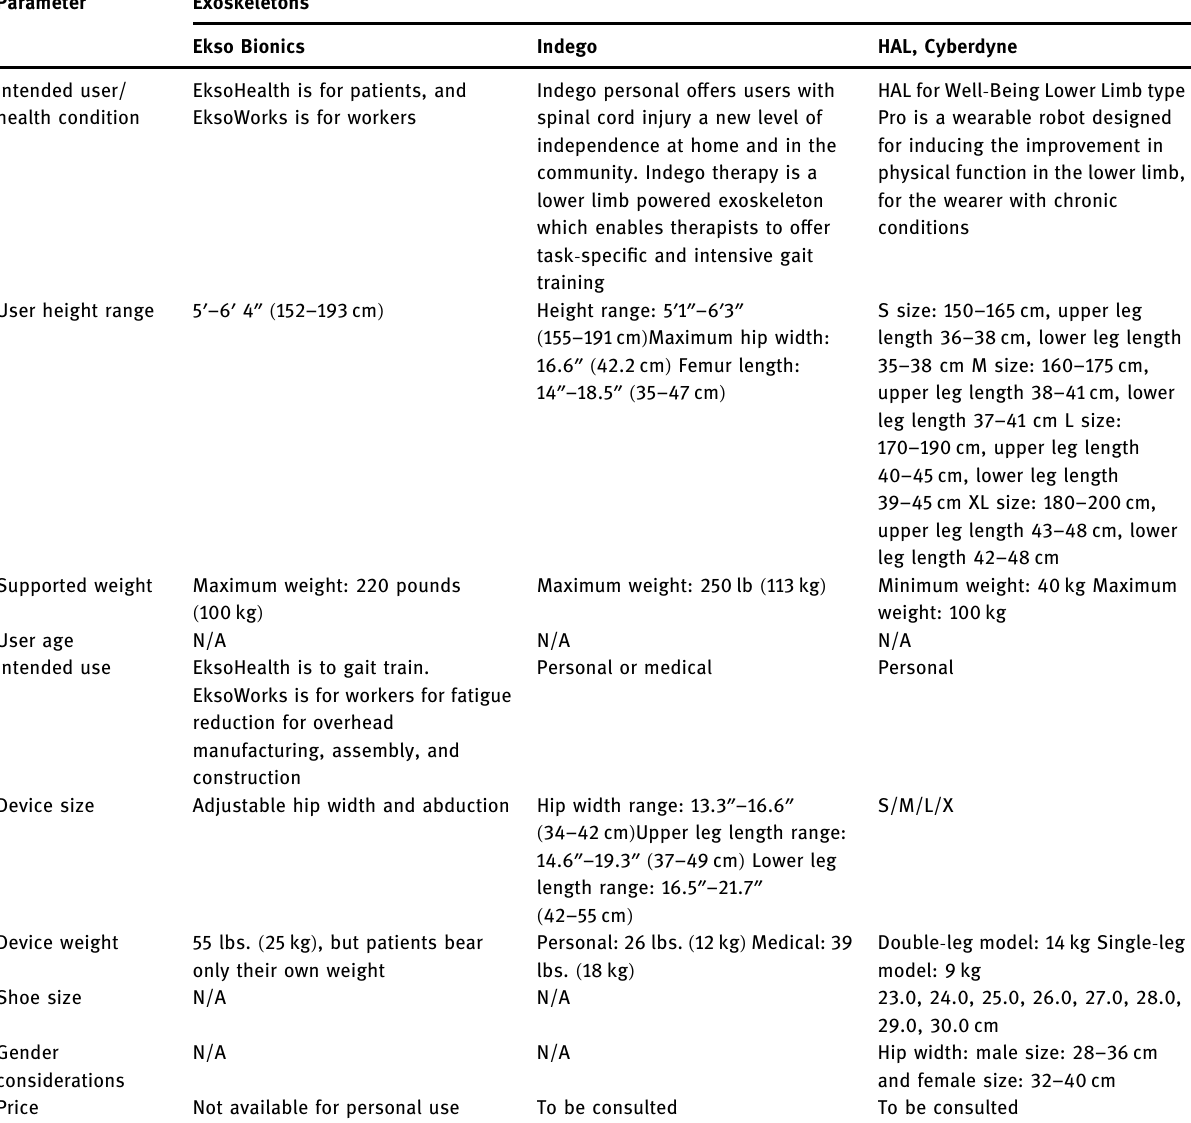
Table 1: User and device characteristics for some commercially available exoskeletons from Ekso Bionics, Indego, and Cyberdyne